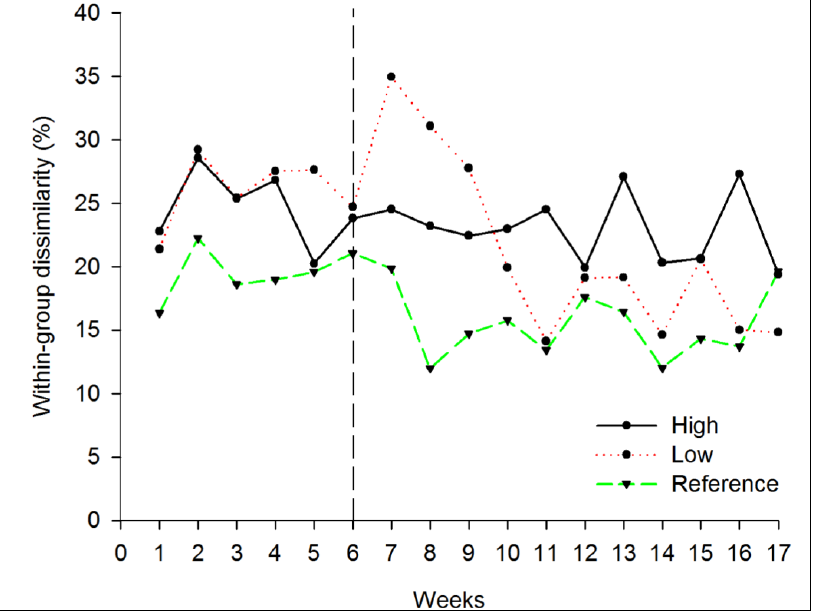
Figure 4. Within-group dissimilarity in rock pools disturbed by draining. The black vertical line represents the beginning of the disturbances. High = draining every diurnal low tide; Low = draining six times during the period, Reference = no draining. Note that high within-group dissimilarity is associated with high beta